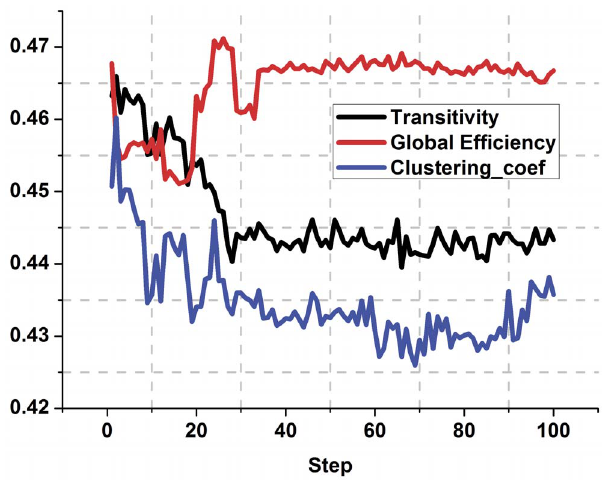
Figure 1. The trend of the network topology parameters during the process of evolution. The black line represents transitivity, the red line indicates the global efficiency, the blue line shows the clustering coefficient. Excluding the impact of random factors, the topology parameters can be considered stable for evolution steps up to